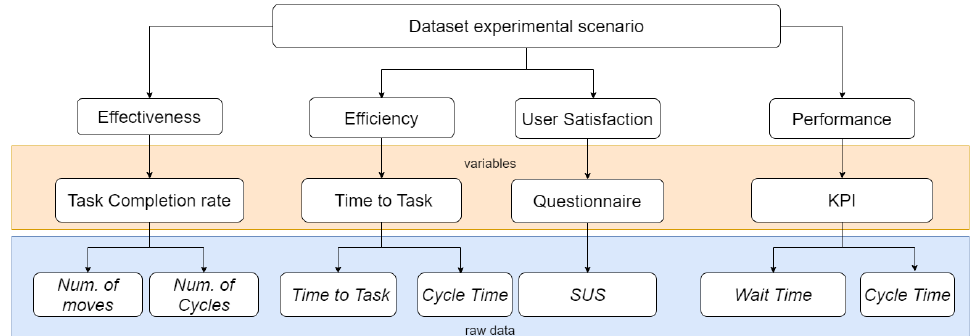
Figure 6. Organization of the dataset for the experimental